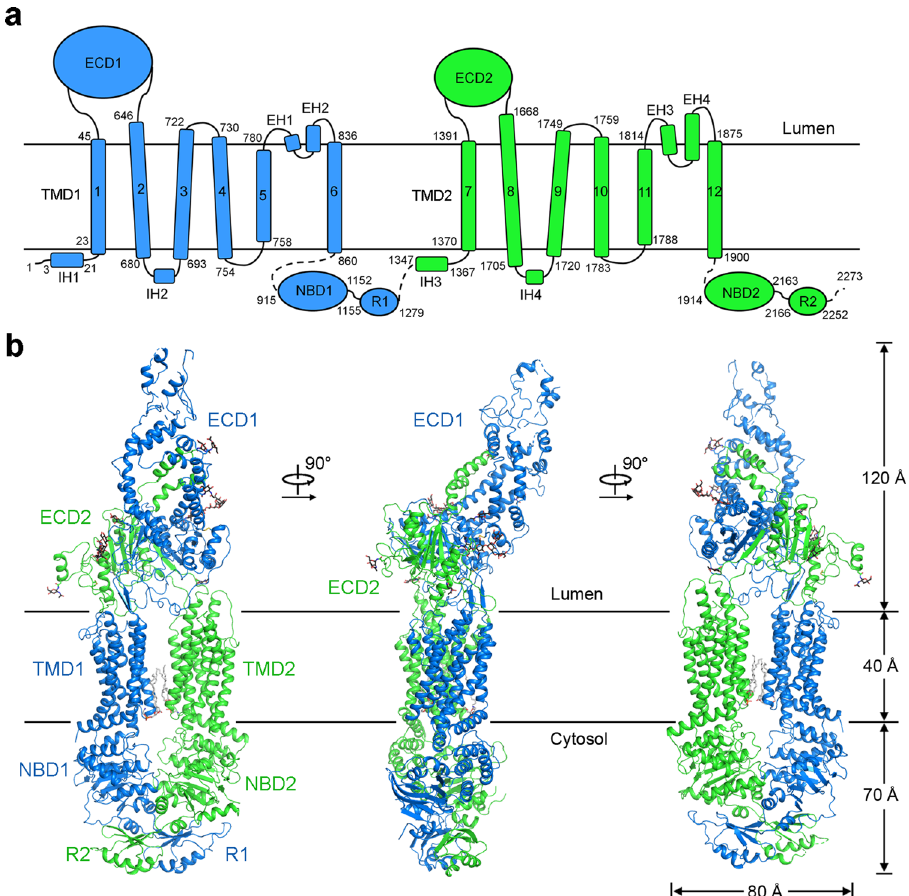
Fig. 1 Overall structure of human ABCA4. a Topological diagram of ABCA4. TMD: transmembrane domain; ECD, extracellular domain; NBD, nucleotide- binding domain; R1 and R2, regulatory domains; IH, intracellular helices; EH, extracellular helices. b Overall structure of ABCA4. The two halves of ABCA4 are colored marine and green for half 1 (TMD1, ECD1, NBD1 and RD1) and half 2 (TMD2, ECD2, NBD2 and RD2), respectively. Two phospholipid molecules bound between TMD1 and TMD2 in the cytoplasmic membrane lea fl et are shown as gray sticks. The N-linked glycans are displayed as black sticks. All structural fi gures were prepared using PyMol (https://www. pymol.org/) or UCSF Chimera 65